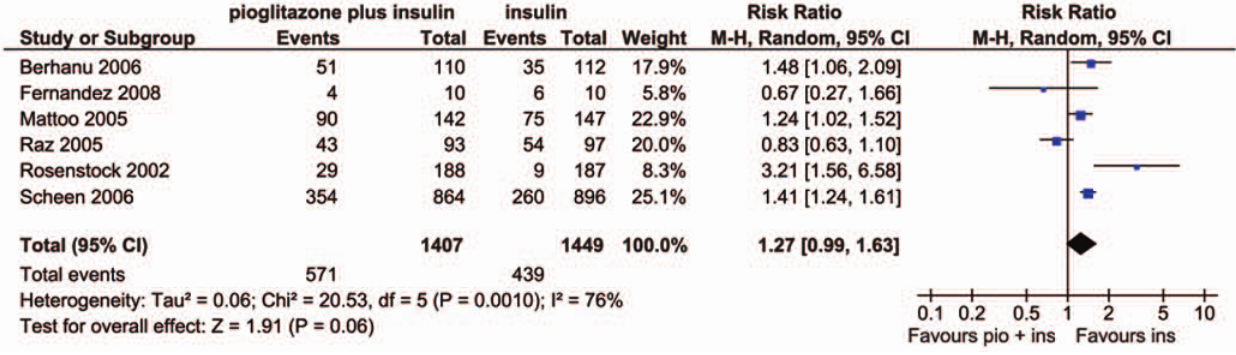
Figure 3. Forest plot of frequency of hypoglycaemia; M-H=Mantel-Haenszel, pio=pioglitazone, ins=insulin.